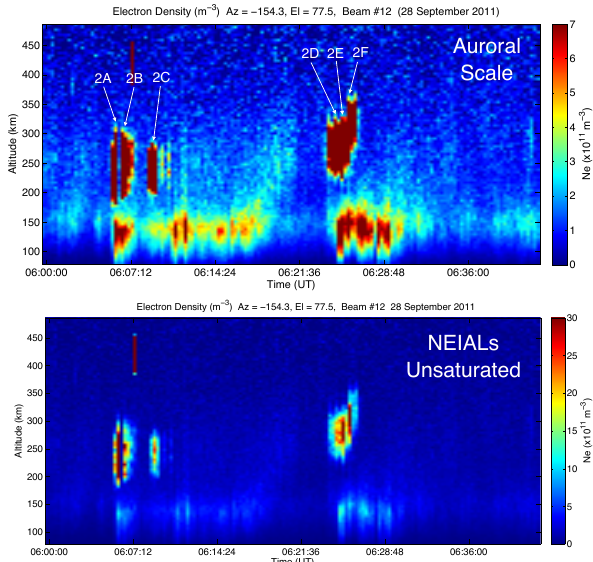
Figure 4. Event 2: top: PFISR electron density profiles, covering a time period of about 40min with a thin, structured auroral arc in zenith. The strong NEIAL returns can be seen in a limited altitude range, mostly between 200 and 300km. The times marked 2A–2F are the times of the NEIAL spectra shown in Fig. 5. Bottom: same time period with intensity scale set so the NEIALs are not oversat-